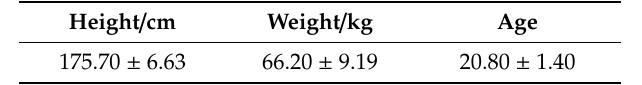
Table 1. Mean and standard deviation of the physical body conditions of the 10